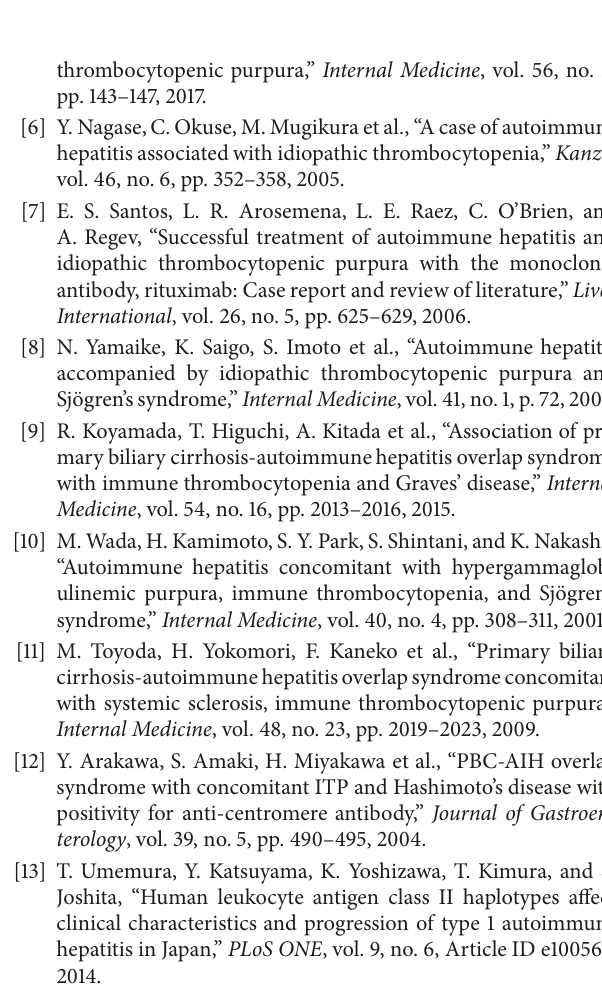
Figure 4: Clinical course. T-Bil: total bilirubin; ALT: alanine aminotransferase; GGT: gamma-glutamyl transferase; TJLB: transjugular liver biopsy; SNMC: Stronger Neo-Minophagen C; PSL: